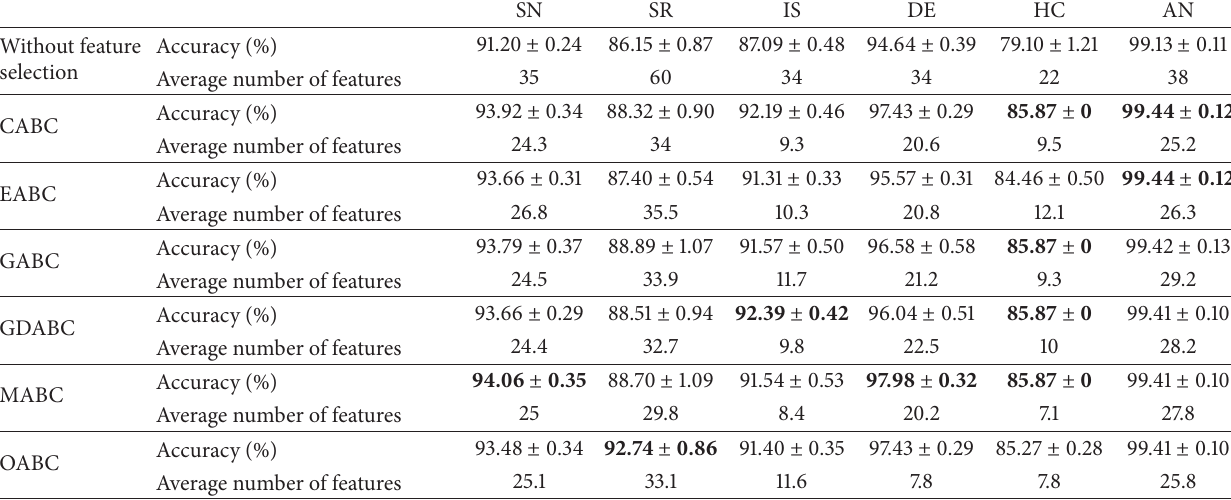
Table 4: Classification accuracy of each ABC algorithm on the tested datasets by using 𝐾 NN as an induction algorithm. SN SR IS DE HC